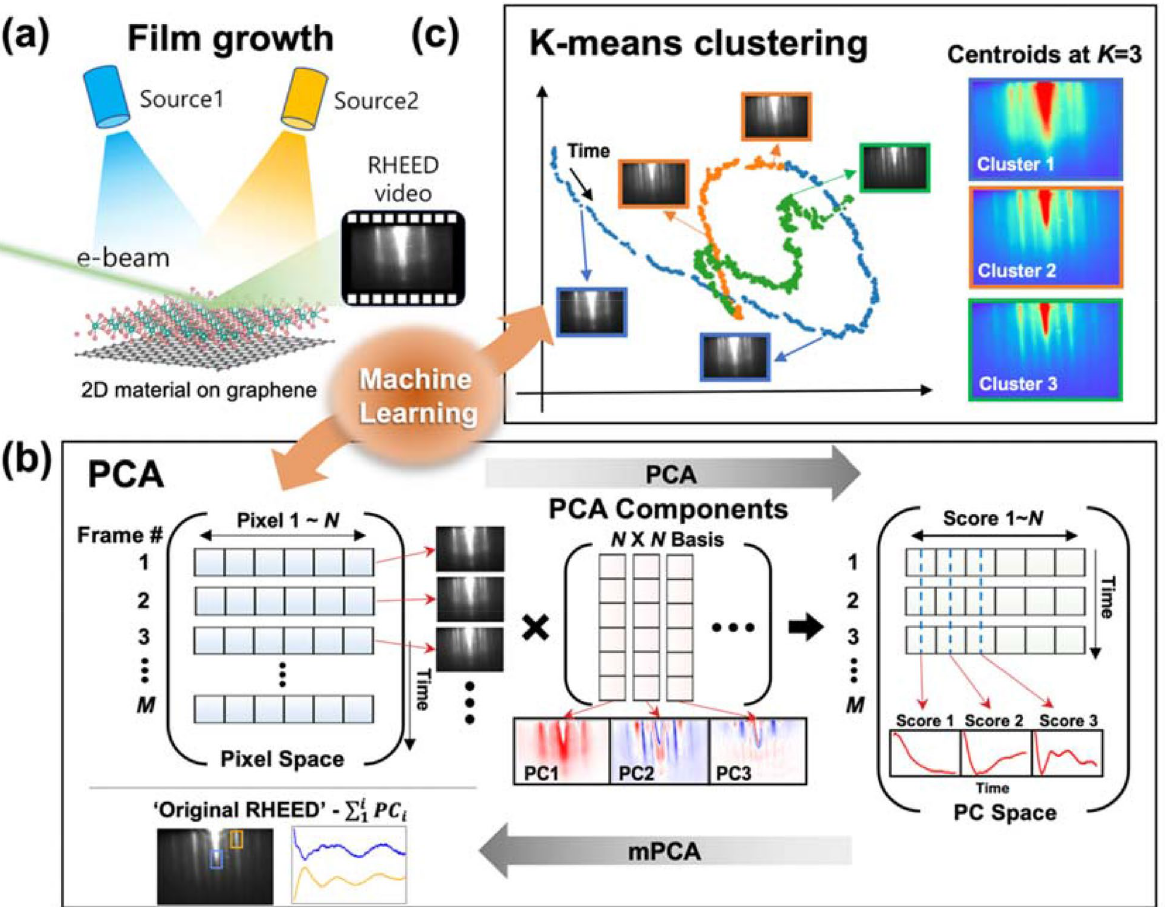
Fig. 1 Overview of ML‑assisted growth analysis. a Schematic of the growth of 2D layered thin films by MBE and acquisition of in situ RHEED video, b , c Processes of PCA and K‑means